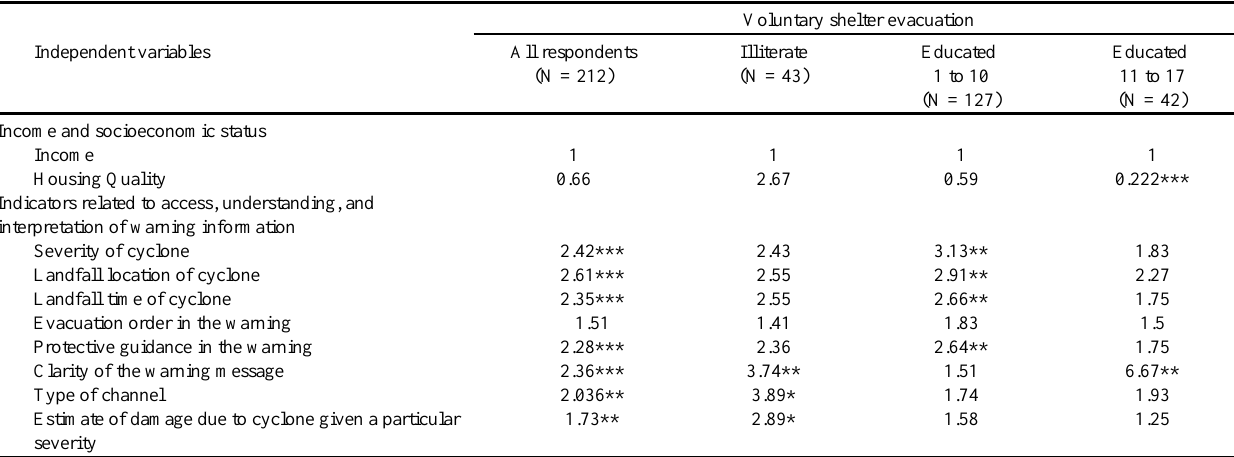
Table 3 . Bivariate logistic regression of evacuation predictors on evacuation among all respondents and separately by level of